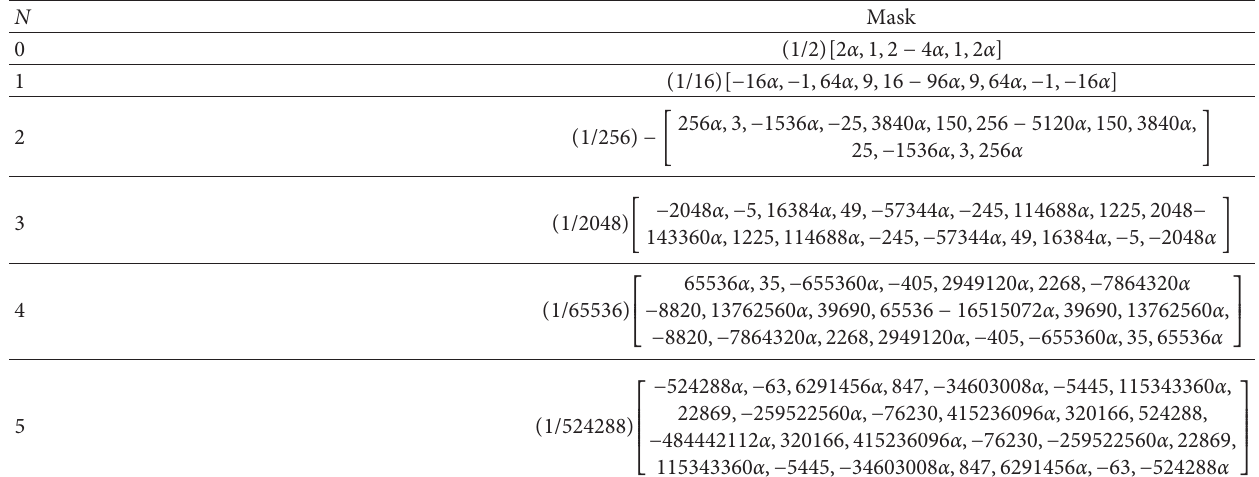
Figure 1: Graphical sketches of the rules of ( 2 N + 2 ) -point primal schemes in (a-b) and of ( 2 N + 3 ) -point primal schemes in (c-d), respectively. (a) Vertex rule. (b) Edge rule. (c) Vertex rule. (d) Edge rule. Table 1: Mask of the ( 2 N + 2 ) -point schemes S a 2 N + 2